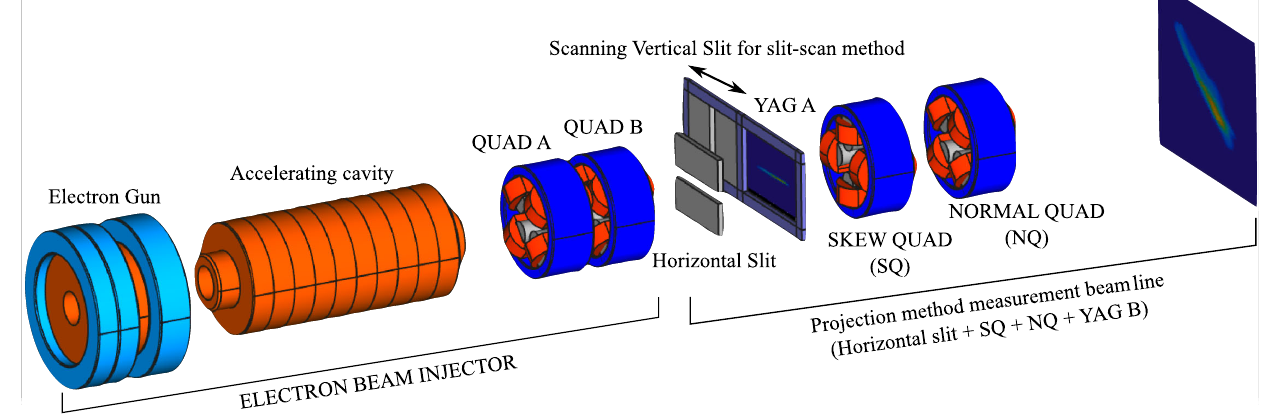
FIG. 2. Beam line configuration at the AWA facility used to demonstrate the projection-based diagnostic . The electron beam injector (electron gun to quad B) generates a variety of different beam conditions for the demonstration. The beam line for this diagnostic consists of a horizontal slit, skew and normal quads, and YAG B. The vertical slit and YAG A are not part of the projection method beam line but were added to benchmark the new method with the slit-scan method